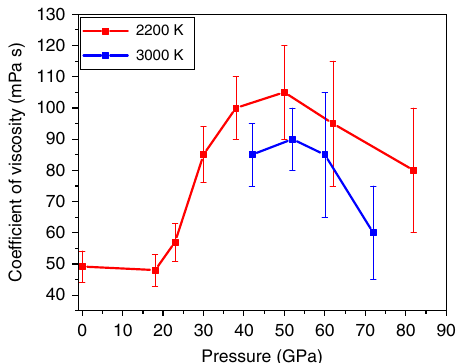
Fig. 4 Coef fi cient of viscosity vs pressure. Red and blue lines represent the data at 2200 K and 3000 K respectively. The error bars are the uncertainties in the coef fi cients of viscosity. The uncertainties of the mean values were determined by considering two possible sources of error in the calculations, that are (i) interval of the time origin of the molecular dynamics steps and (ii) oscillatory nature of the stress auto correlation function after it decays to zero, which is integrated to obtain the coef fi cient of